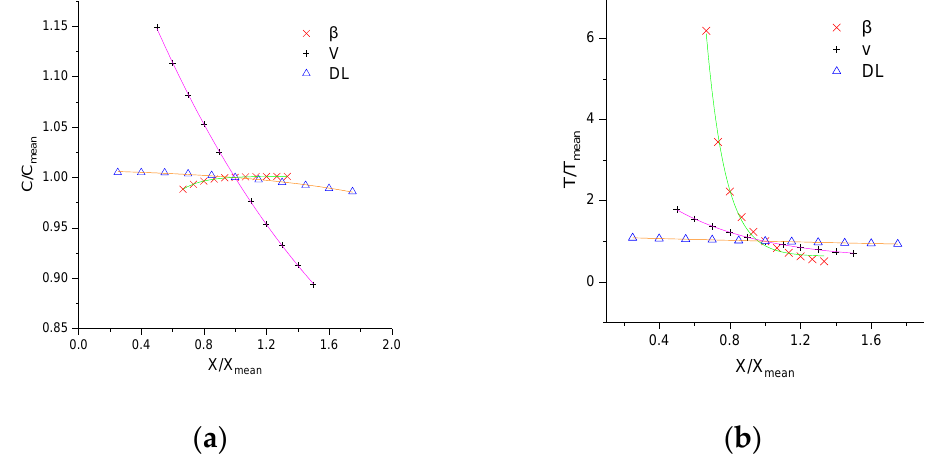
Figure 6. Local sensitivity analysis results of three parameters: ( a ) refers to the ratio of value and average of peak concentration; ( b ) refers to the ratio of value and average of arrival peak time (note: abscissa is the ratio of value and average of